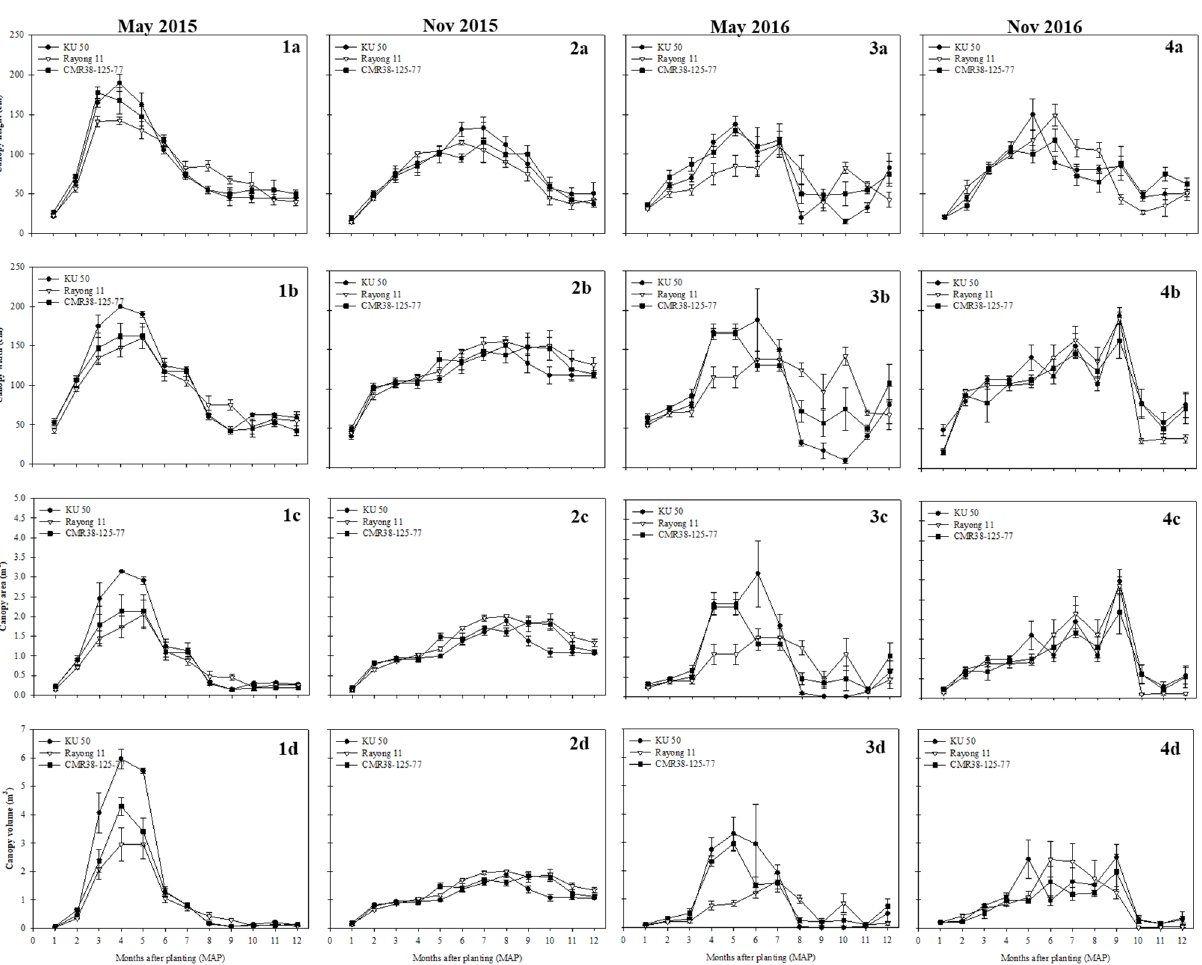
Figure 3. Canopy height ( a ), canopy width ( b ), canopy area ( c ) and canopy volume ( d ) of three cassava genotypes when planted in May (1,2) and November (3,4) of 2015 and 2016. The bars indicate standard deviation of means.